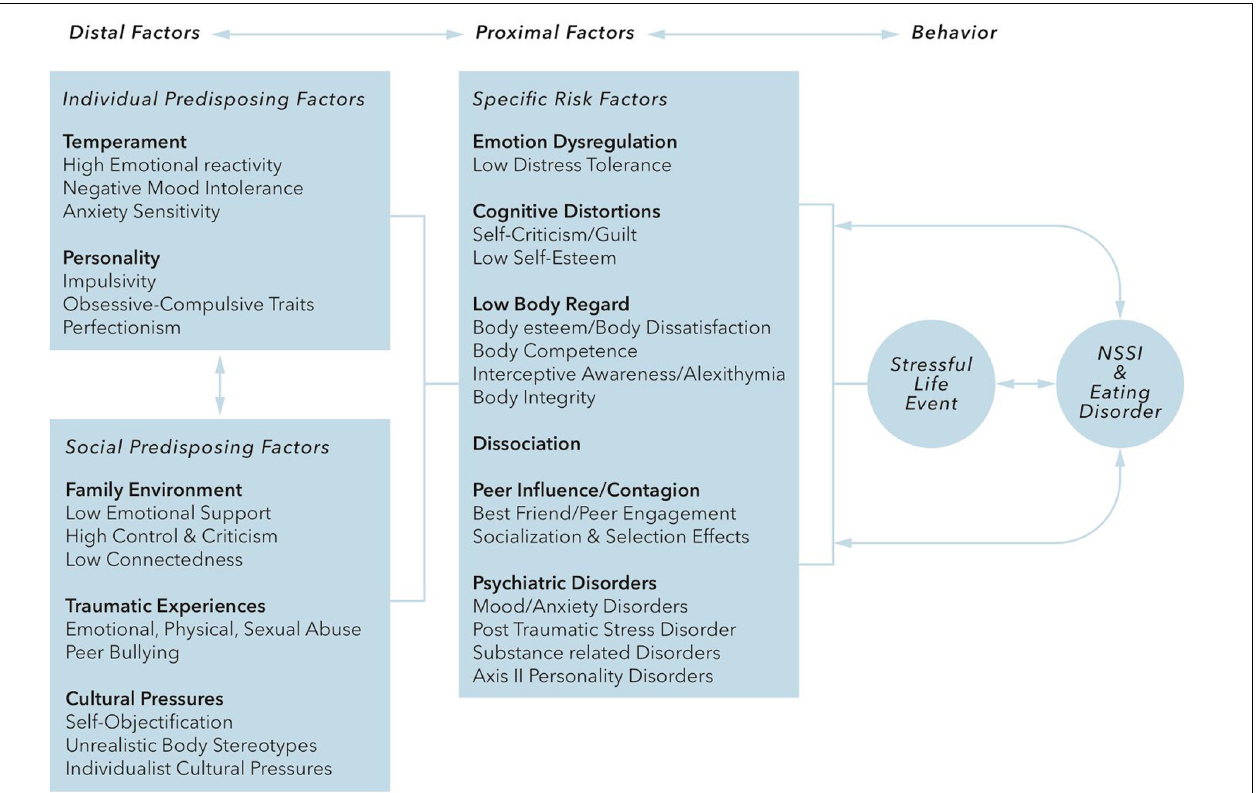
FIGURE 1 | Claes and Muehlenkamp (51) distinguish “distal” risk factors that include temperament (high emotional reactivity, negative mood intolerance, anxiety sensitivity) and personality traits (impulsivity, obsessive-compulsive traits, perfectionism), cultural factors, family factors, and traumatic interpersonal experiences, and “proximal” risk factors that include emotion dysregulation, cognitive distortions, low body regard, dissociation, peer pressure/contagion and comorbid psychiatric disorders. It is hypothesized that these risk factors interact with each other and with stressful events and that the internal distress caused by these interactions is regulated by behaviors of NSSI and/or EDs, which in turn can influence or reinforce the proximal risk factors.